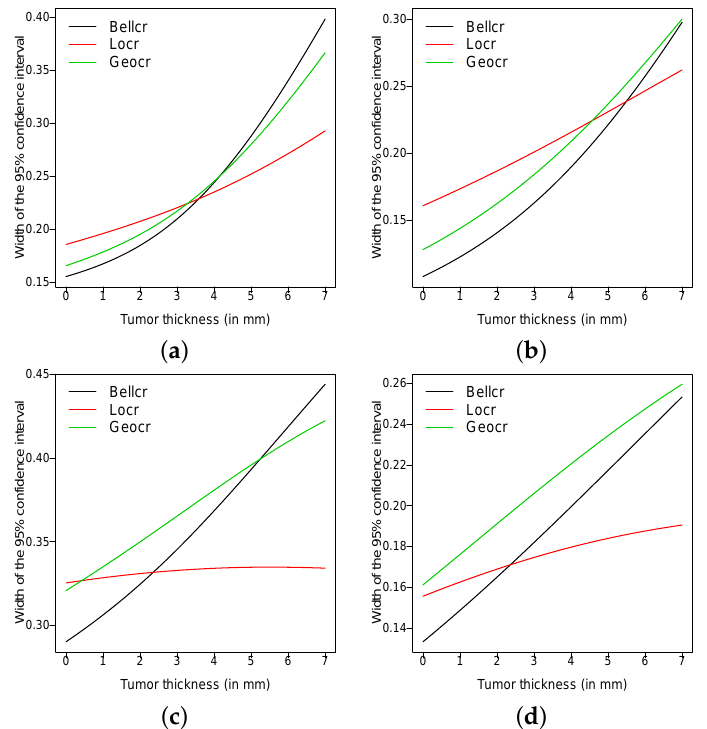
Figure 5. Width of the 95% confidence interval for the conditional cure rate: ( a ) without ulceration and t 0 = 0 year, ( b ) without ulceration and t 0 = 5 years, ( c ) with ulceration and t 0 = 5 years and ( d ) with ulceration and t 0 = 10 years.